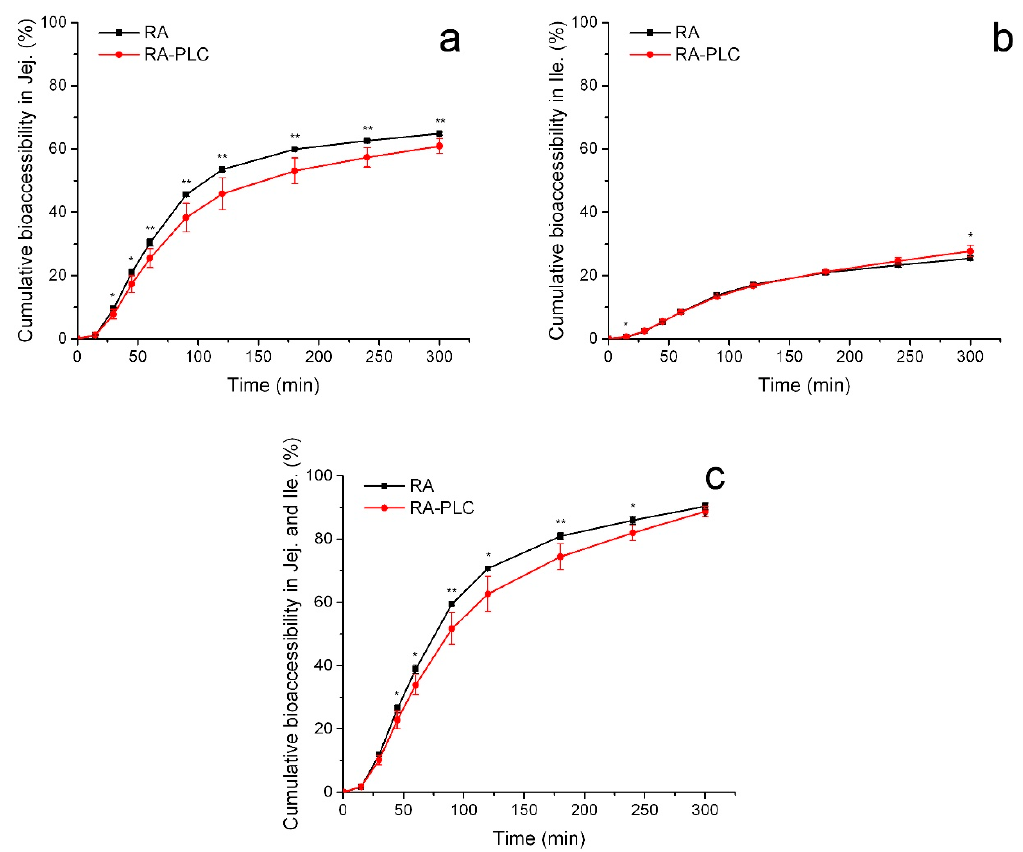
Figure 6. Cumulative bioaccessibility of RA and RA-PLC in jejunum ( a ), ileum ( b ), and the sum ( c ). * p < 0.2 and ** p < 0.1 between RA and RA-PLC ( n = 3, mean ± SD).